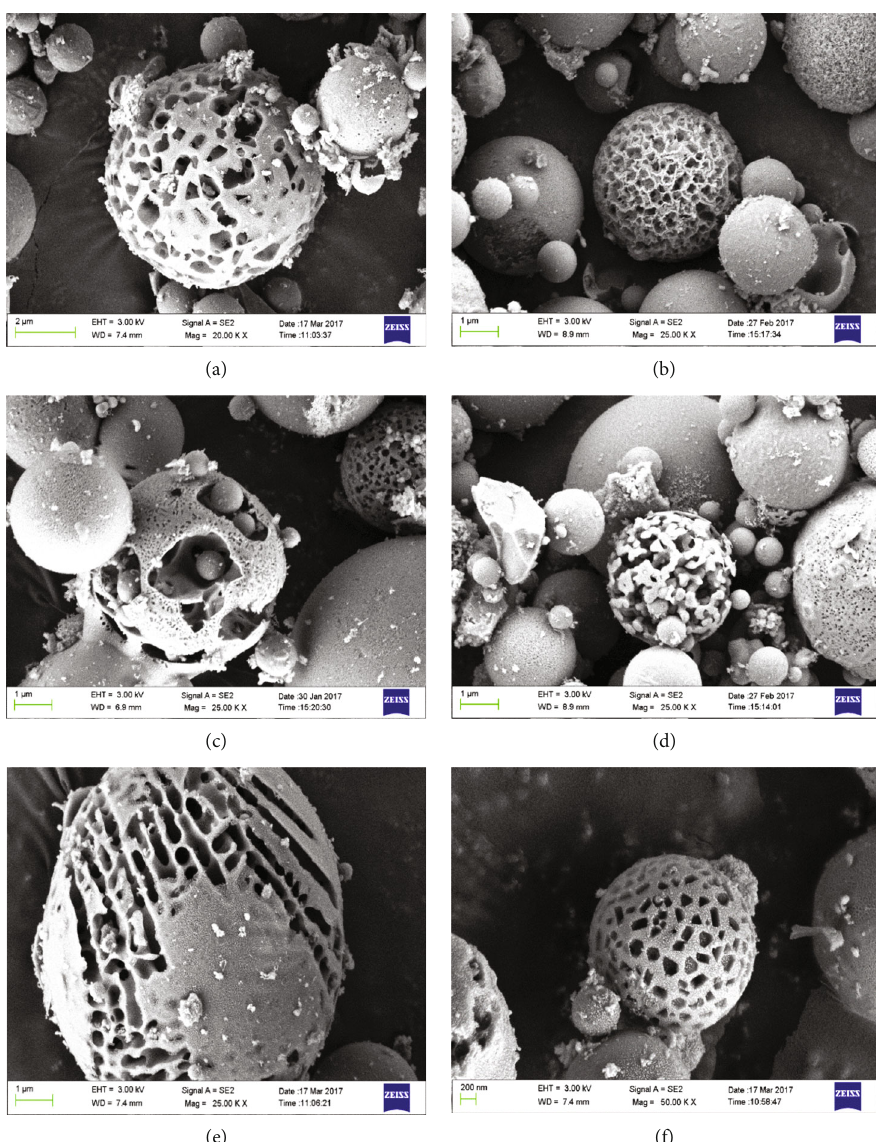
Figure 10: FESEM images (a – f) of conc. HCl-treated